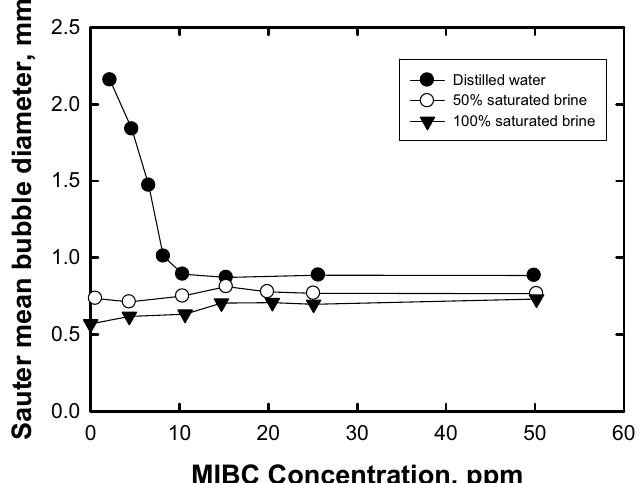
Fig. 5 Sauter mean bubble diameter as a function of MIBC concentration and electrolyte concentration (after Laskowski et al., 2003) 12) .[the term “brine” used here stands for saturated solution of KCl + NaCl (about 6 mole/L)].